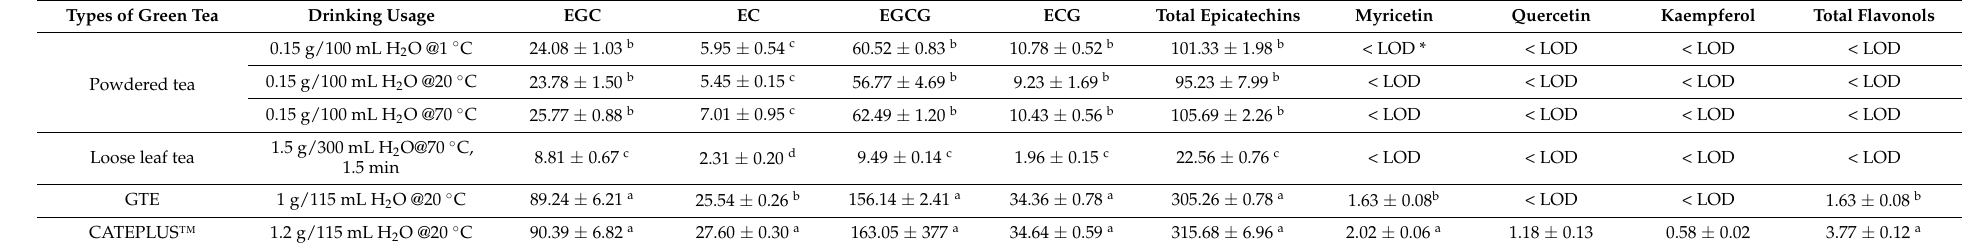
Table 2. Epicatechins and flavonols from green tea samples according to drinking usage (mg/g dry